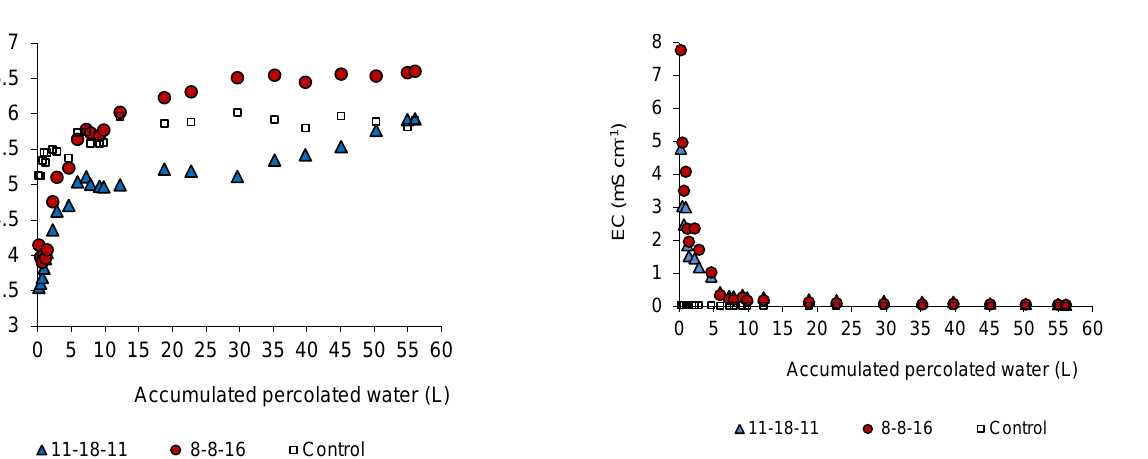
Figure 1. Acidity (pH) of leachates from fertilized and control columns as a function of the volume of percolated water (average of three replicates).